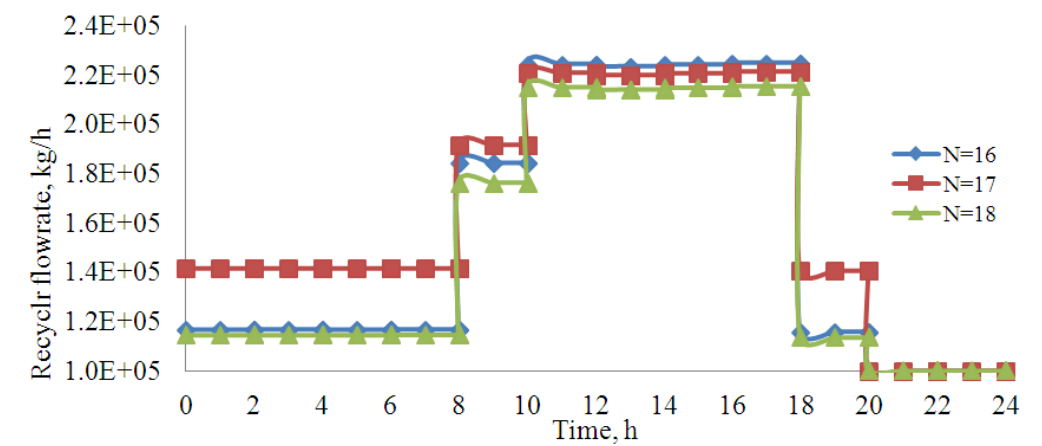
Figure 8. Optimum brine recycle flow rate throughout profile. Note: In y axis, E+05 = 10 5 and likewise.